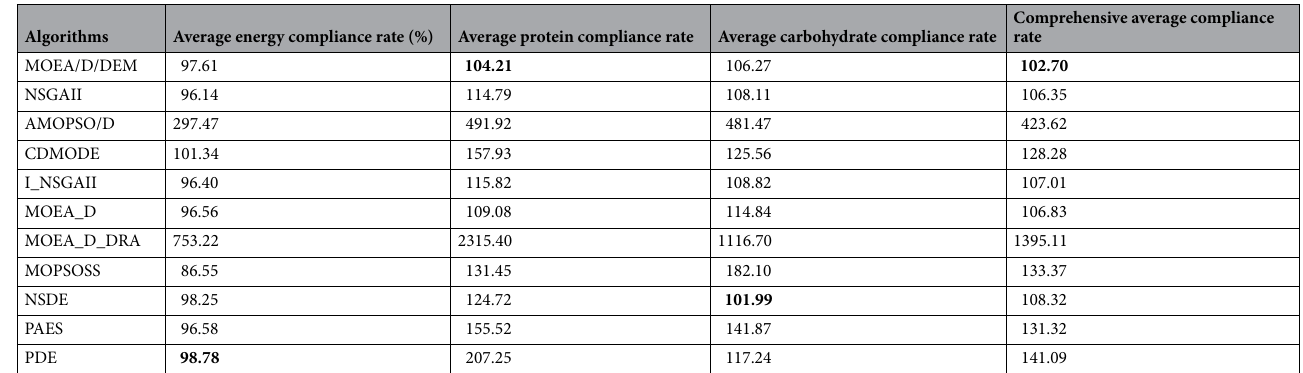
Table 7. The average nutrient compliance rate of the meal plan of all algorithms. The best of the comparison results are in